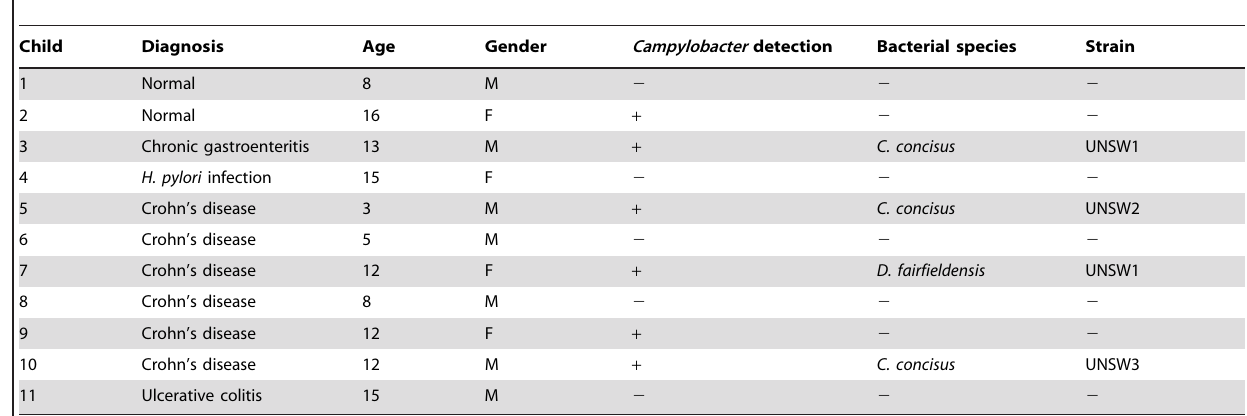
Table 1. Mucosa-associated bacteria isolated from child intestinal biopsies using the Ham’s F-12 enrichment-filtration method.